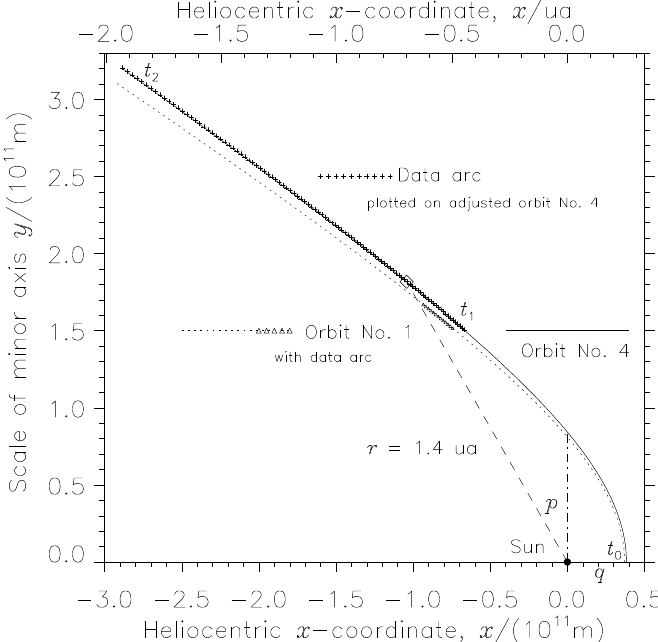
Figure 2. Hyperbolic orbit solutions for ‘Oumuamua (post perihelion) (cf. Tables1–3 ). Perihelion distance q ; semi-latus rectum p . orbit No. 1 : Observations from 18 to 24 October 2017. The time interval with observations is indicated near t 1 . Orbit No. 4: Observations from 14 October 2017, 10:32:41 UTC ( t 1 ) to 2 January 2018, 11:28:29 UTC ( t 2 ). Perihelion on 9 September 2017, 12:10:45 UTC ( t 0 ) (Minor Planet Center). The data arc is shown on the adjusted trajectory from time t 1 to t 2 . The heliocentric distance r (cid:5) = 1.4 au is